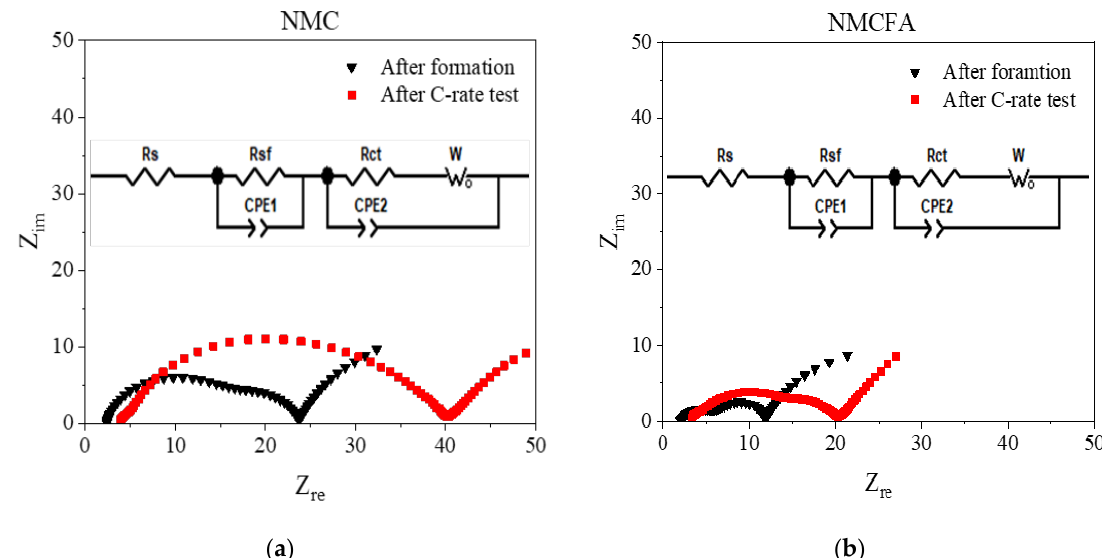
Figure 6. Nyquist plots of ( a ) NMC and ( b ) NMCFA before and after the rate capability test with insets of equivalent circuits.